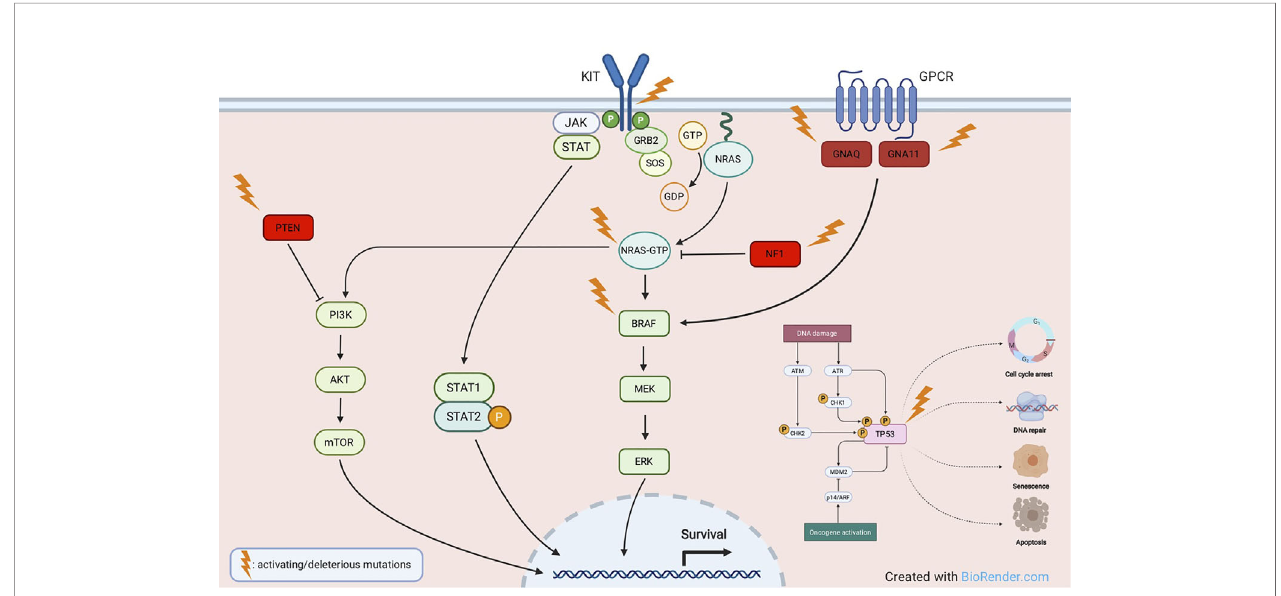
FIGURE 2 | Main molecular pathways involved in melanomagenesis. Activating mutations are commonly detected in oncogenes like KIT, NRAS, BRAF, GNAQ, GNA11 , whereas deleterious mutations most frequently affect tumor suppressor genes like NF1, PTEN and TP53